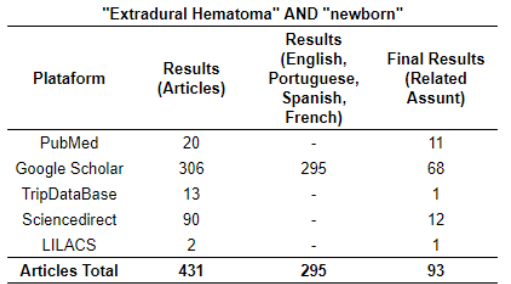
Table 2. Results with the term “Extradural Hematoma” AND